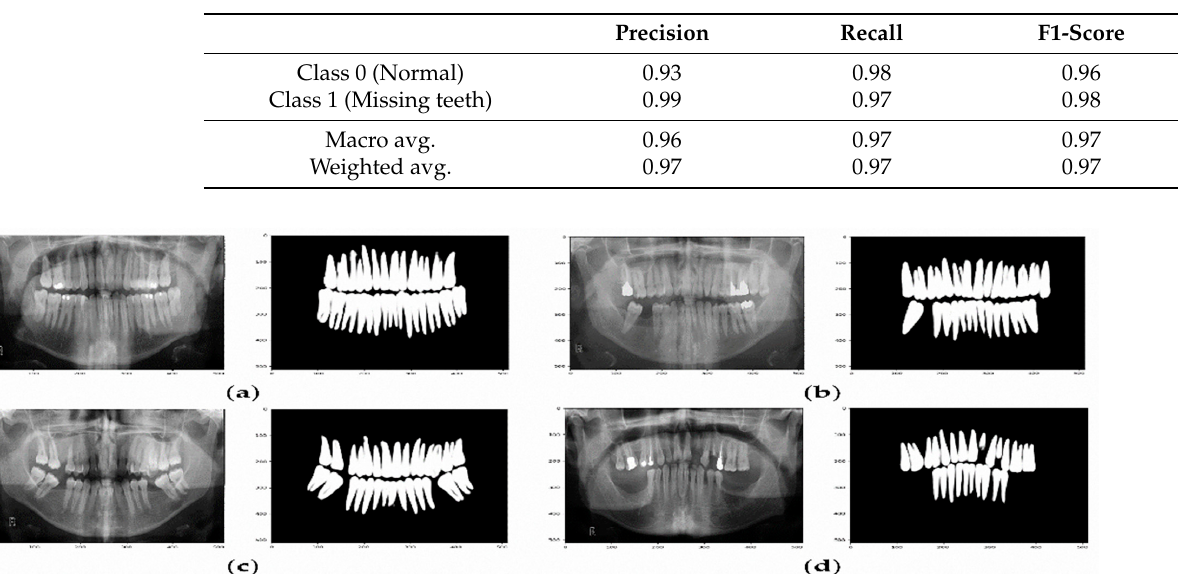
Table 4. Confusion matrix of U-net model.